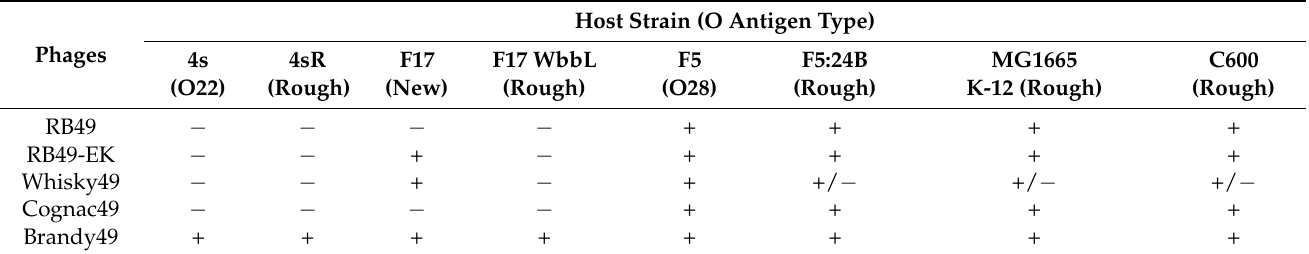
Table 1. Plaque formation by RB49-like bacteriophages on different E. coli